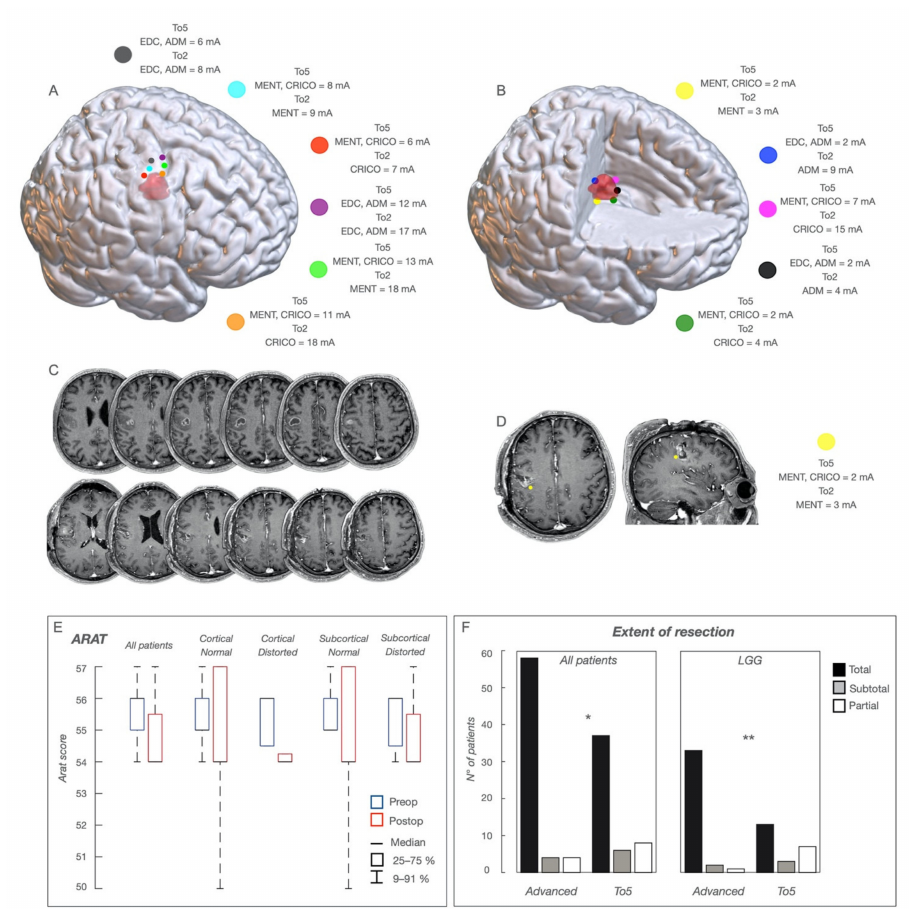
Figure 5. Functional Maps and Resection. A case of glioma involving, in the non-dominant hemisphere, the vPM and the face area of M1 (zone-3), in a representative patient who experienced several left face focal seizures. The location of the tumor is shown in ( C ) (sequential axial post-GDT1-weighted images); the tumor appeared as a solid, well-demarcated mass with contrast enhancement nodules. The patient was submitted to a sleep surgery with the aid of the advanced brain mapping technique. A cartoon depicting, in the NMI space, the cortical functional map is shown in ( A ). The tumor volume is in pink. The stimulated sites are shown as colored dots. At the cortical level, HF-To5 and HF-To2 evoked face (Mentalis and Cricothyroid) MEPs at variable cMT (To5 ranging between 6 and 13 mA; To2 ranging between 7 and 18 mA) with a clear functional segregation between the anterior and posterior regions. At the subcortical level ( B ), sites evoking hand or face muscle MEPs at the lowest sMT were identified. Those with the lowest sMT at HF-To5 and HF-To2 (yellow, blue, black and dark green) were used as the margin of resection; sites with the lowest sMT at HF-To5 but with sMT at HF-To2 > 4 mA (representative site indicated by a magenta dot) were removed. The post-operative MR is shown in ( D ) (sequential axial post-GD-T1 weighted images). A representative location of a functional site identified by subcortical mapping is shown at the posterior and inferior margin of the tumor as a colored yellow dot, superimposed to the preoperative axial and coronal post-GD-T1-weighted images. HF-To5 evoked MEPs of Mentalis and Cricothyroid at an sMT of 2 mA; HF-To2 evoked only cricothyroid MEPs at an sMT of 3 mA, indicating that these fibers belong to the posterior functional component. A histo-molecular diagnosis showed a grade-III IDH-wildtype glioblastoma, TERT Intact. ( E ) Action-Research-Arm-Test (ARAT) evaluation score performed in the group of patients with tumors involving the hand-knob region of M1; the pre- (preop) and post-operative (45 days of surgery) (postop) scores are presented for the whole group (all patients), patients with normal cortical map, patients with normal subcortical map, patients with distorted cortical map and patients with distorted subcortical map. Scores are presented as 25–75% median (rectangle) and 9–91% (edge of the box). ( F ) Comparison of Extent of resection achieved in the 66 patients with tumors involving M1, in whom resection was guided by the advanced motor mapping technique (Advanced) and in the 51 patients with similar tumors, in whom resection was guided by the traditional To5 motor mapping technique (To5); the same comparison is presented for patients with low-grade gliomas (LGG); data are expressed as EOR classes: Total resection, subtotal, or partial; * p < 0.5; ** p <